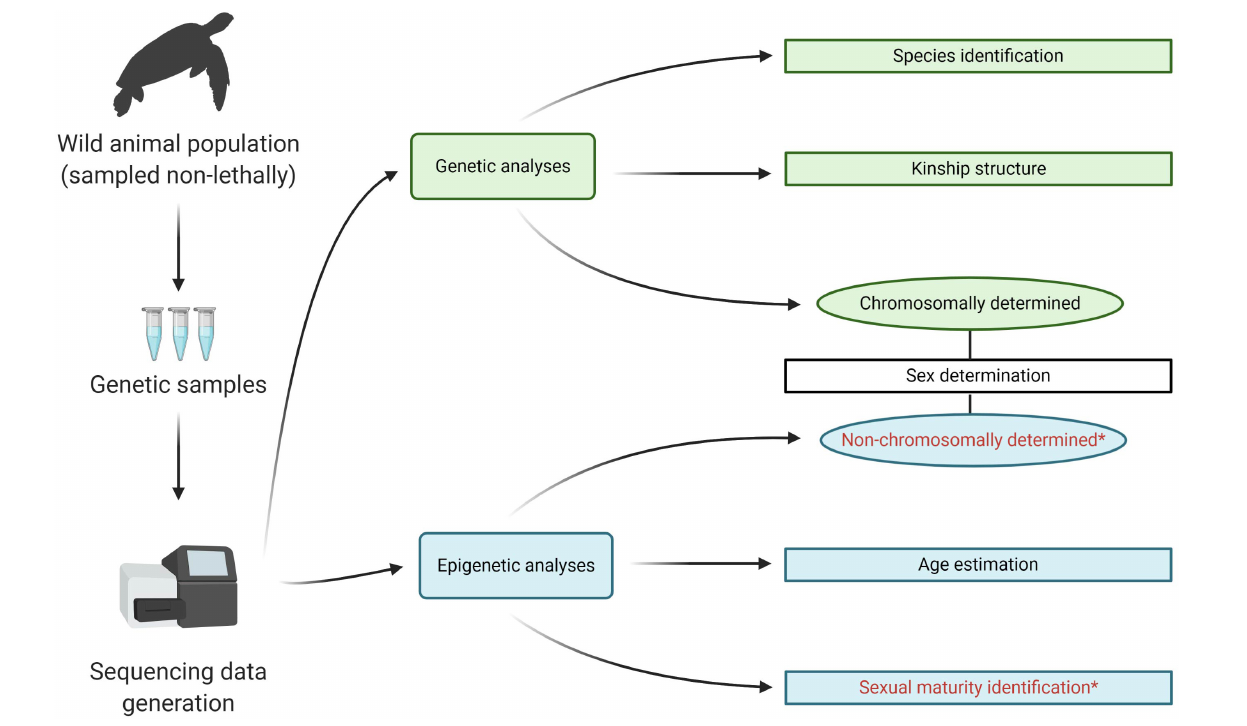
FIGURE 1 | Examples of a genetic and epigenetic analyses of vertebrate population biology. Emerging epigenetic analyses hypothesized in this study are denoted with